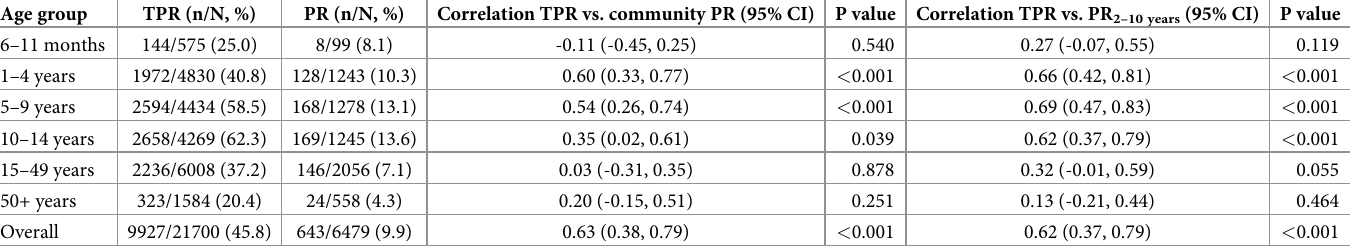
Table 2. The relationship between health facility Test-Positivity Rate (TPR) (matched to 2 months period around each cross-sectional surveys) and community Par- asite Rate (PR) or age-standardized PR 2–10 years stratified by age groups. Age group TPR (n/N,